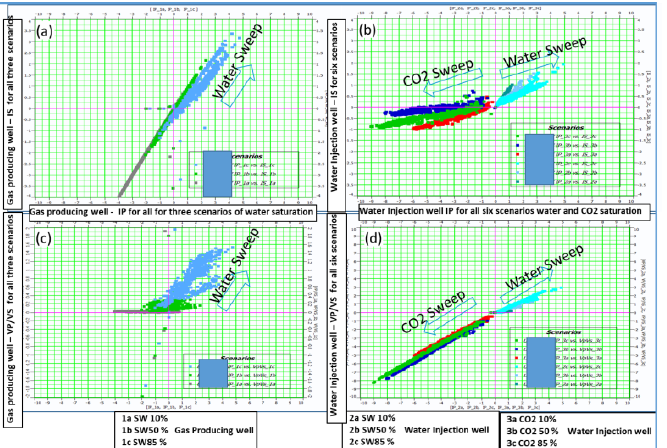
Figure 4. ( a ) Cross-plot of P impedance versus IS (shear impedance) for three water saturation sce- narios of the gas production well; ( b ) cross-plot of P impedance versus IS (shear impedance) for six water saturation scenarios of CO 2 saturation of the water injection well; ( c ) cross-plot of P impedance versus VP/VS ratio for three water saturation scenarios of the gas production well, and ( d ) cross-plot of P impedance versus VP/VS for six water saturation and CO 2 saturation scenarios of the water injection well.